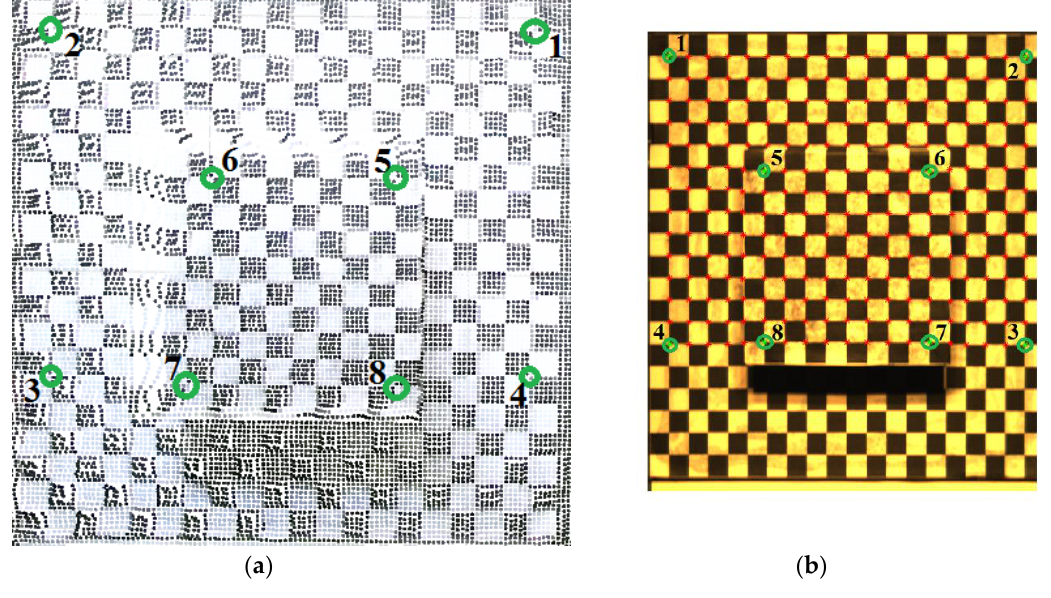
Figure 6. ( a ) The 3D coordinate of the selected reference points from Kinect V2 3D point clouds; ( b ) The hyperspectral image coordinate of the selected reference points achieved automatically using the corner detected method (red marks).